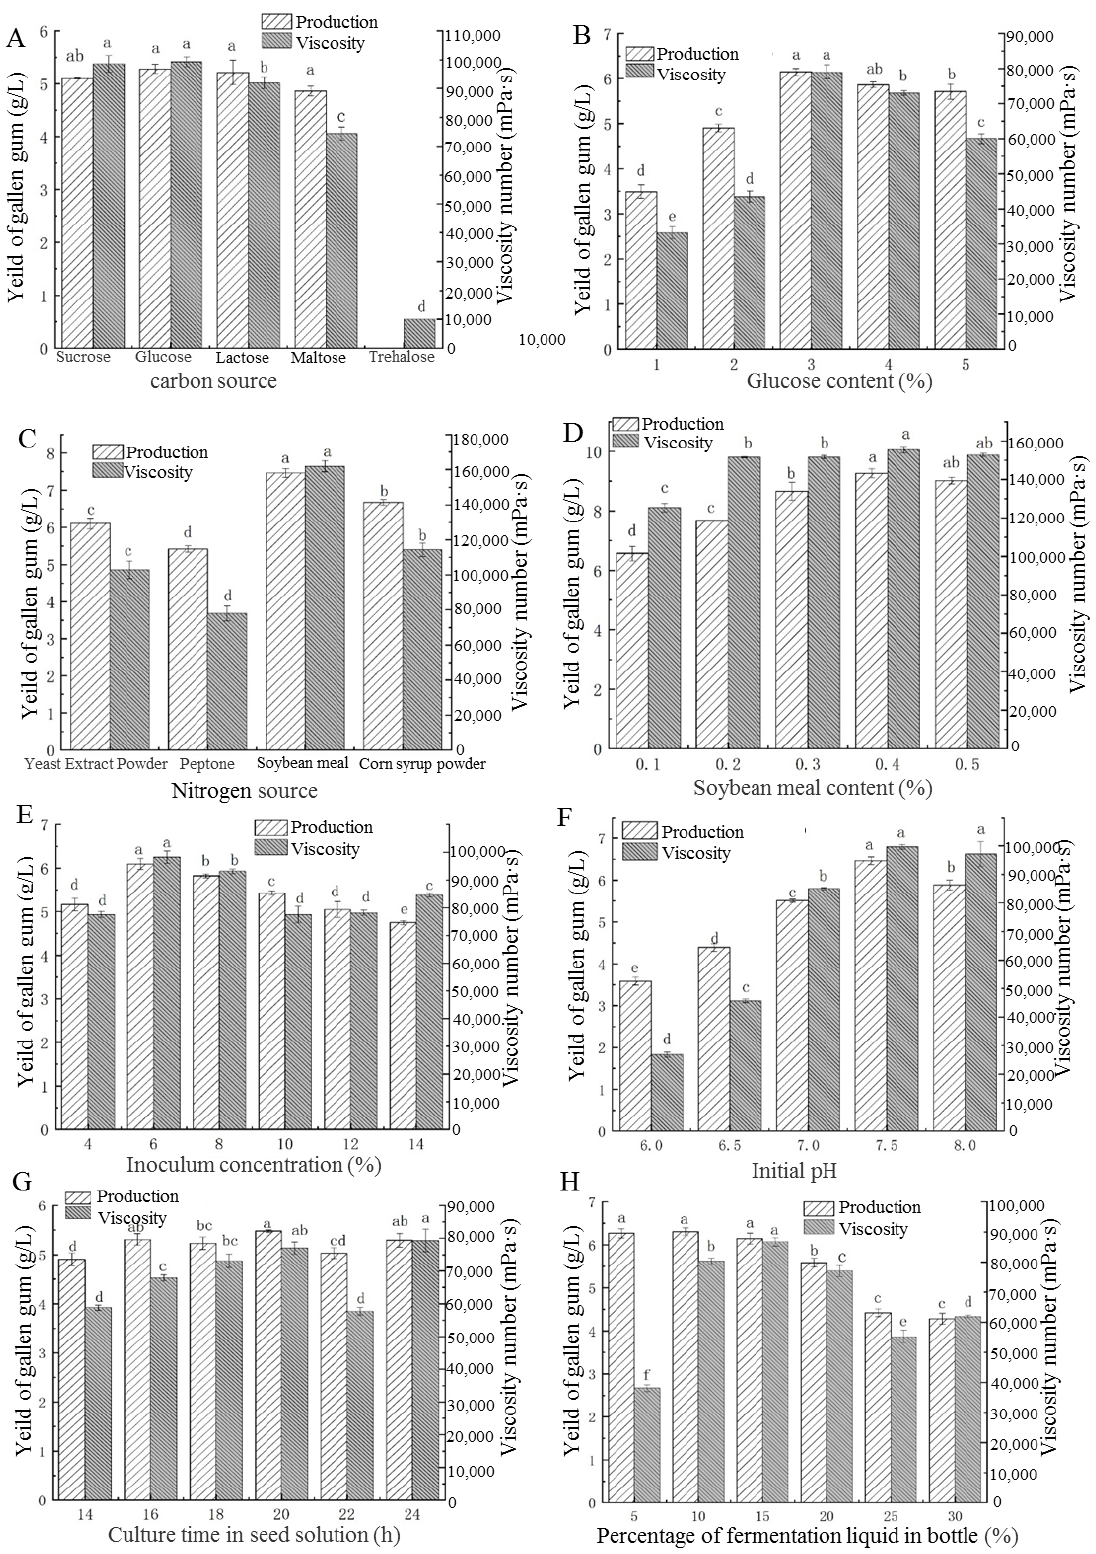
Figure 5. Optimization of fermentation conditions of mutant strain 519 by single-factor experiments. ( A ) Carbon sources; ( B ) Glucose content; ( C ) Nitrogen sources; ( D ) Soybean meal content; ( E ) Inoculum concentration; ( F ) Initial pH; ( G ) Culture time in seed solution; and ( H ) Percentage of fermentation liquid in bottle. Different letters represent a significant difference between the two in a strain ( p <